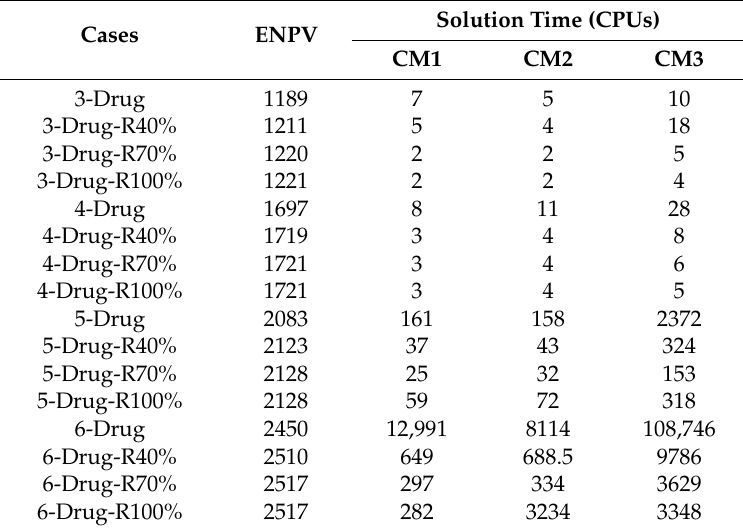
Table 3. Resource constraint perturbation results for CM1, CM2 and CM3.